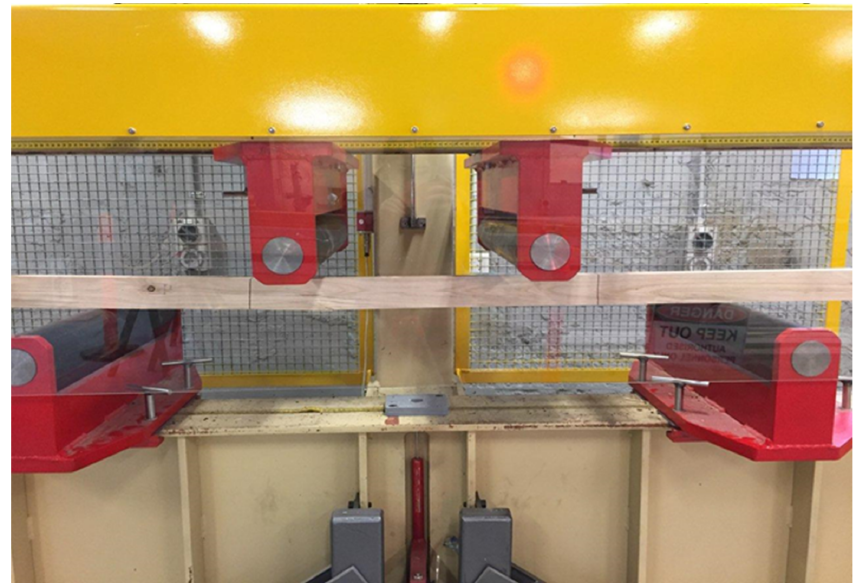
Figure 5. Four-point bending test setup using Calibre STFE10 Machine.